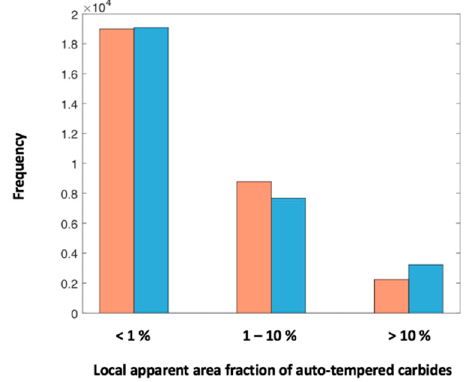
Figure 9. Histogram where the degree of auto-tempering in the specimens cooled at 100 °C/s is represented by the blue bars and the specimens cooled at 1000 °C/s by the brown bars.